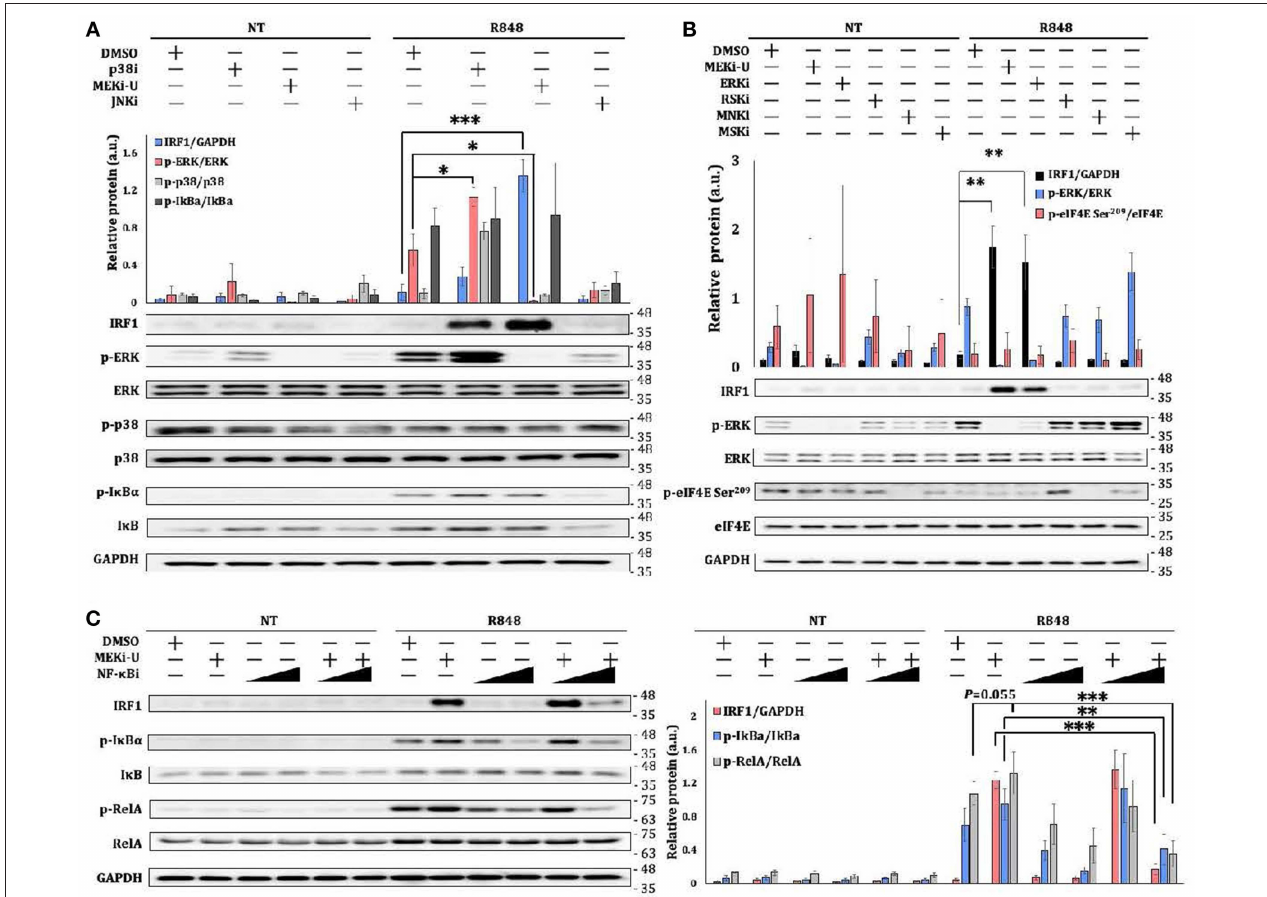
FIGURE 4 | IRF1 is unlocked through the activation of NF- κ B pathway. (A–C) Immunoblot analysis and quantitative densitometry of the indicated proteins in lysates from BMDM activated with R848 in the presence or absence of MEKi-U, p38 MAPK inhibitor p38i, or JNK MAPK inhibitor JNKi (A) , or MEKi-U, ERK inhibitor (ERKi), RSK inhibitor (RSKi), MNK inhibitor (MNKi), or MSK inhibitor (MSKi) (B) , or MEKi-U, and NF- κ B inhibitor NF- κ Bi (C) for 12h (A,C) or 8h (B) . Blots are representative of 4 independent experiments. Molecular weight (kDa) markers are indicated on the right side of the blots. Quantified data are means ± SD from all experiments. * P < 0.05, ** P < 0.01, and *** P < 0.001 by unpaired Welch’s t -test. n.s., not significant.